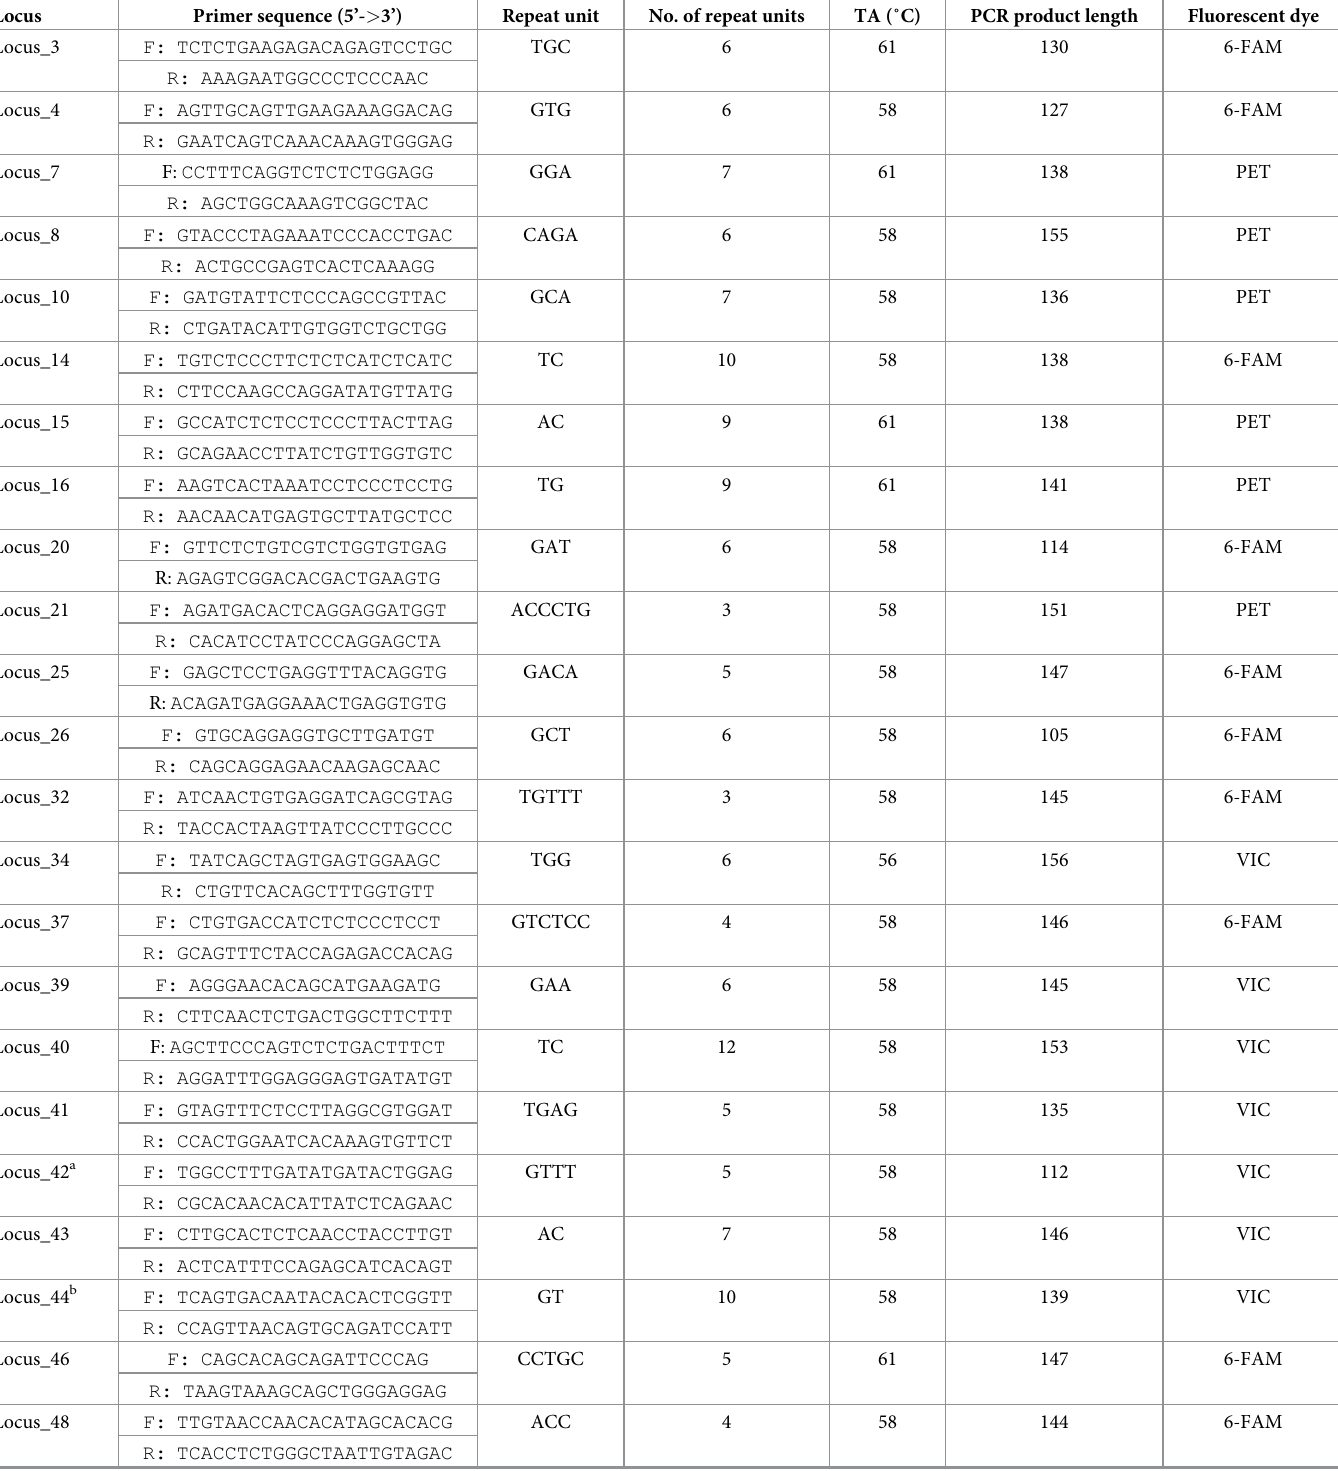
Table 1. Primer information on 26 polymorphic microsatellite markers according to the sambar transcriptome sequences. Locus Primer sequence (5’- >